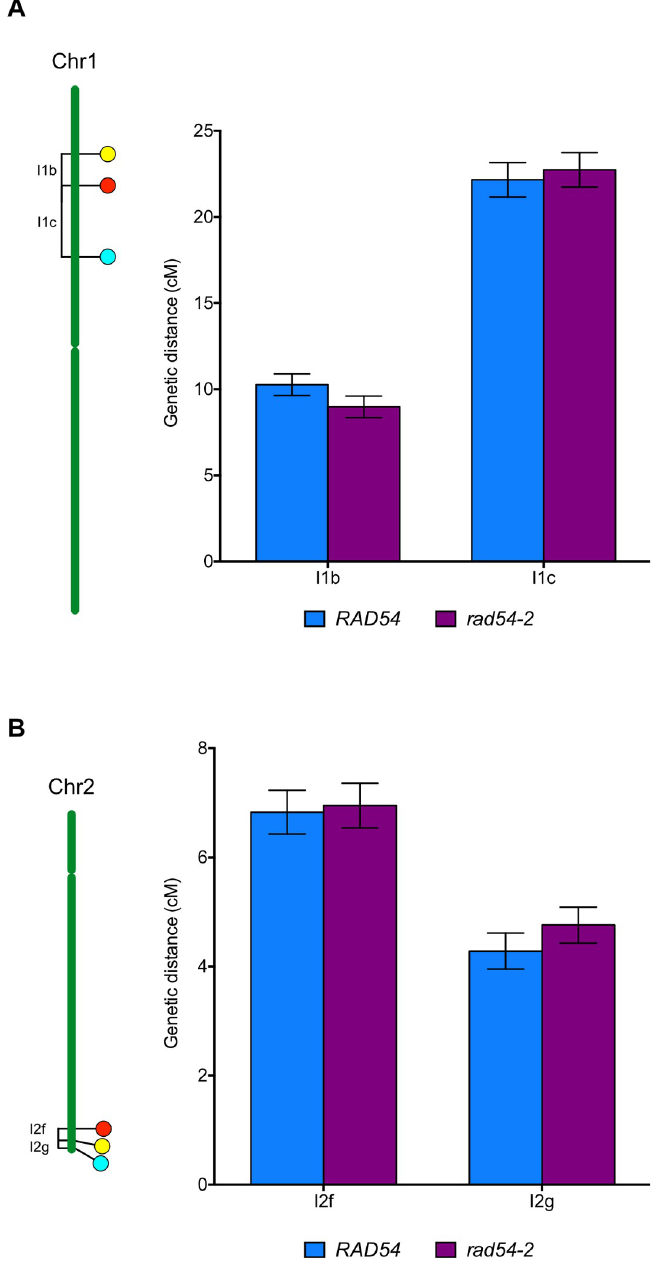
Fig 3. Crossing-over is not affected in rad54-2 mutant meiosis. Genetic distances (in centiMorgans, cM) measured from fluorescent tetrad analyses in marked intervals on (A) chromosome 1 (I1b and I1c) and (B) chromosome 2 (I2f and I2g). Bars indicate mean ± SD. On all intervals, WT and rad54 do not significantly differ (p > 0.05;